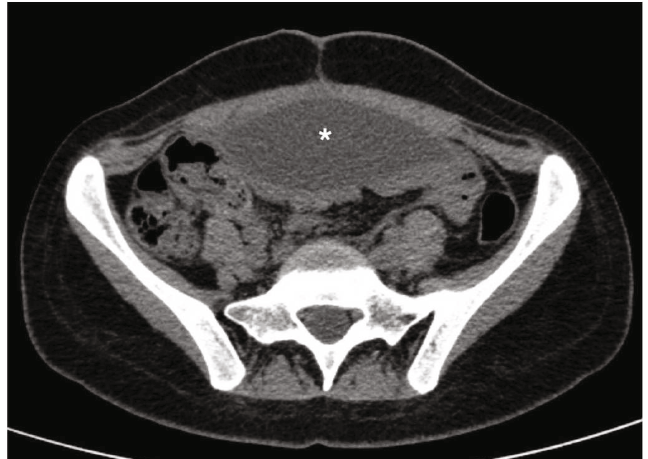
Figure 2: Axial section of the abdominal CT. The asterisk represents the pseudocyst inside the abdominal cavity. This seems to be the cause of the system malfunctioning.